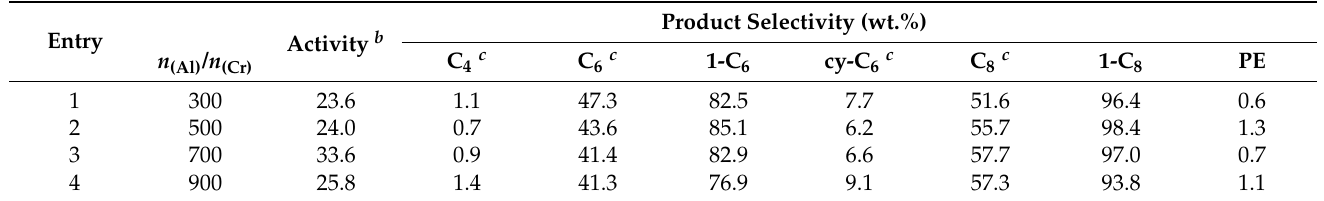
Table 3. Evaluation of the effect of Al/Cr molar ratios on the catalytic performance of the L2-based catalyst a .